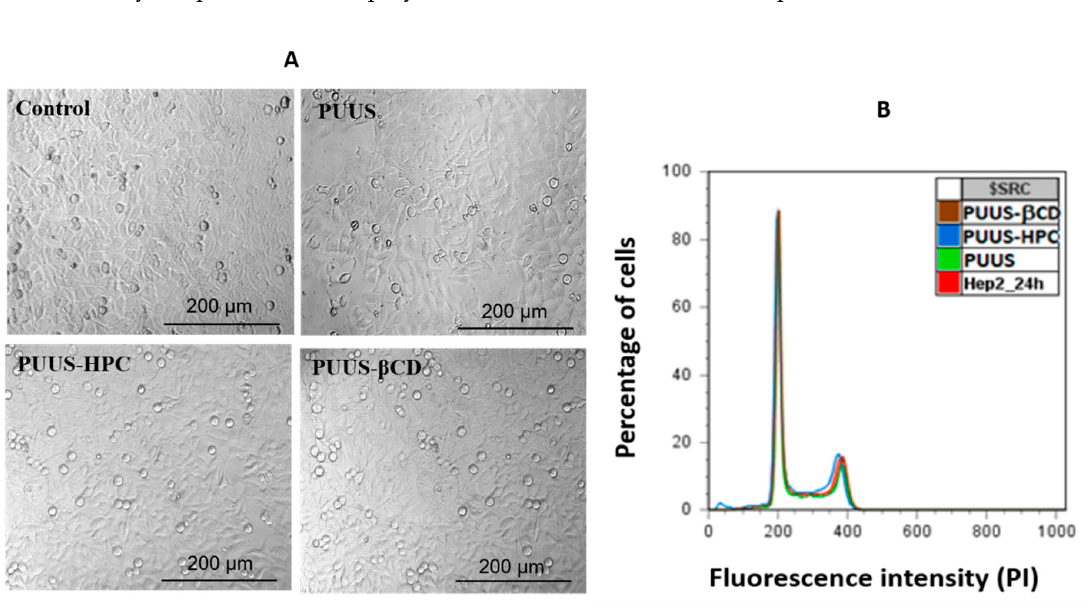
Figure 11. ( A ) Cell morphology of HEp2 cells on the nanofibrous mat (PUUS) and nanofibrous composite mats (PUUS-HPC and PUUS- β CD) surfaces; ( B ) cell cycle flow cytometry histograms.